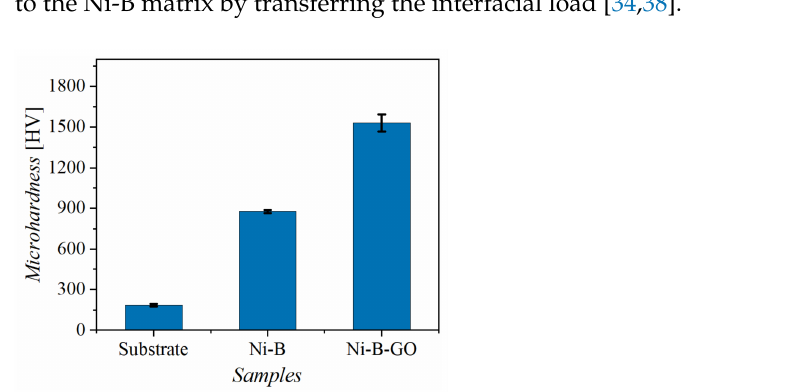
Figure 5. Microhardness of the substrate, Ni-B coating, and Ni-B-GO coating.